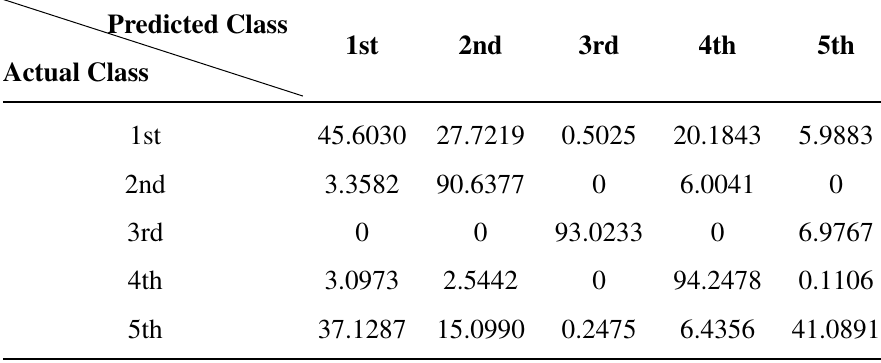
Table 6. Confusion matrix for K-means, mean shift-filtered patches, 500 × 500-pixel patches and parameter Set III (values in %).